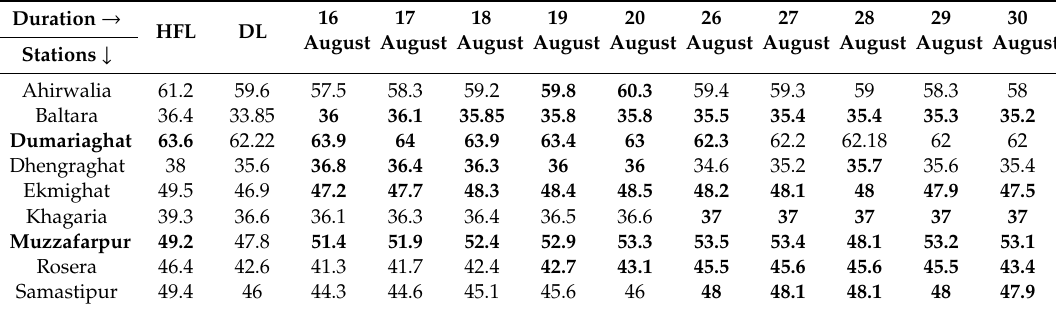
Table 5. Central Water Commission (CWC) station-wise water levels (m) during 16–20th and 26–30th August, 2017 for LGBO-1 (Lower Ganga basin organizations). The water levels were compared with Danger Level (DL) and Highest Flood Level (HFL). The bold indicates water level above DL and HFL (Data source: